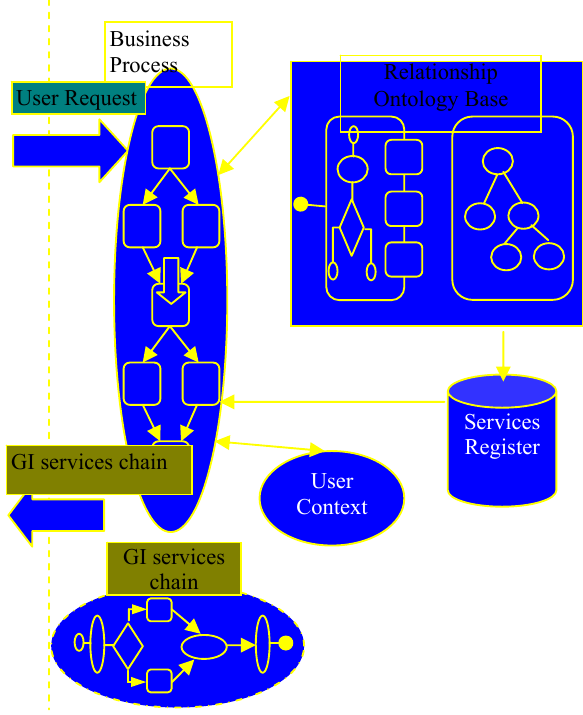
Figure 2. The GI service framework considering the